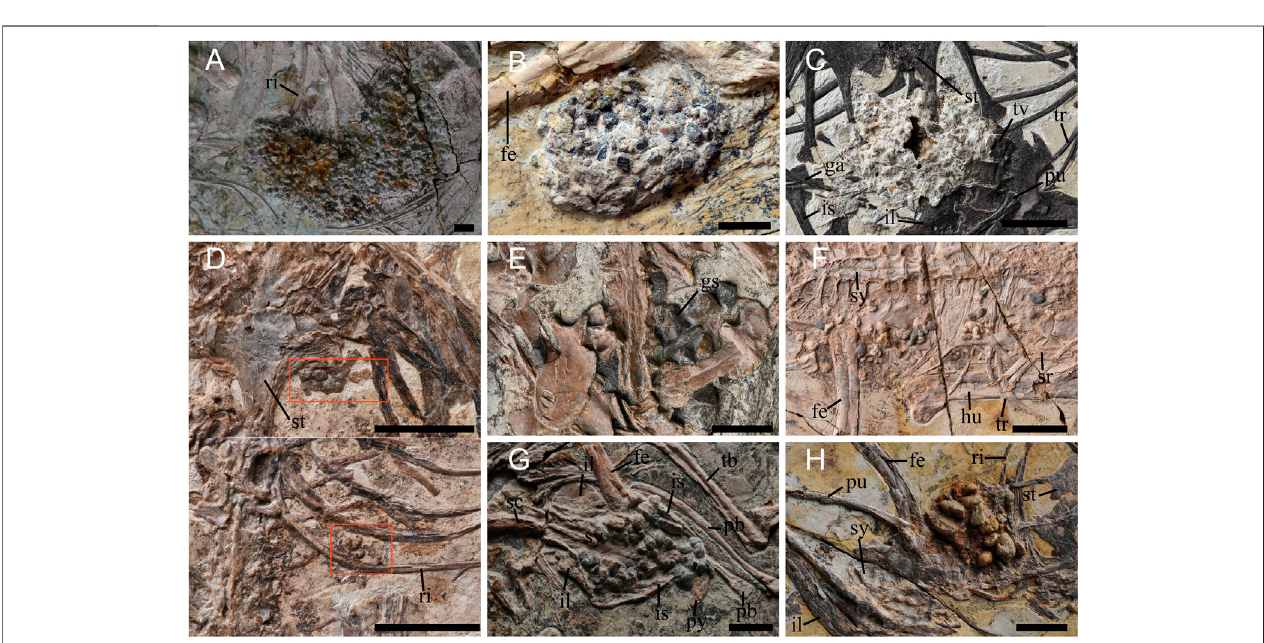
FIGURE 2 | Comparison of purported gastral masses in Early Cretaceous Jehol paravians and birds. (A) . Caudipteryx STM4-5 (Oviraptorosauria); (B) . Jeholornis STM2-15 (Jeholornithiformes); (C) . Archaeorhynchus IVPP V17075 (Ornithuromorpha); (D) . Bohaiornis IVPP V17963 (Enantiornithes); (E) . Iteravis IVPP V23346 (Ornithuromorpha); (F) . Archaeorhynchus IVPP V14287 (Ornithuromorpha); (G) . Dingavis IVPP V20284 (Ornithuromorpha); (H) . Bellulornis IVPP V17970 (Ornithuromorpha); Anatomical abbreviations: fe, femur; ga, gastralia; gs, gastroliths; hu, humerus; il, ilium; is, ischium; pb, pubes; pu, pubis; py, pygostyle; ri, rib; sc, scapula; sr, sternal rib; st, sternum; sy, synsacrum; tb, tibiotarsus; tr, thoracic rib; tv, thoracic vertebra. Scale bar equals 1 cm.